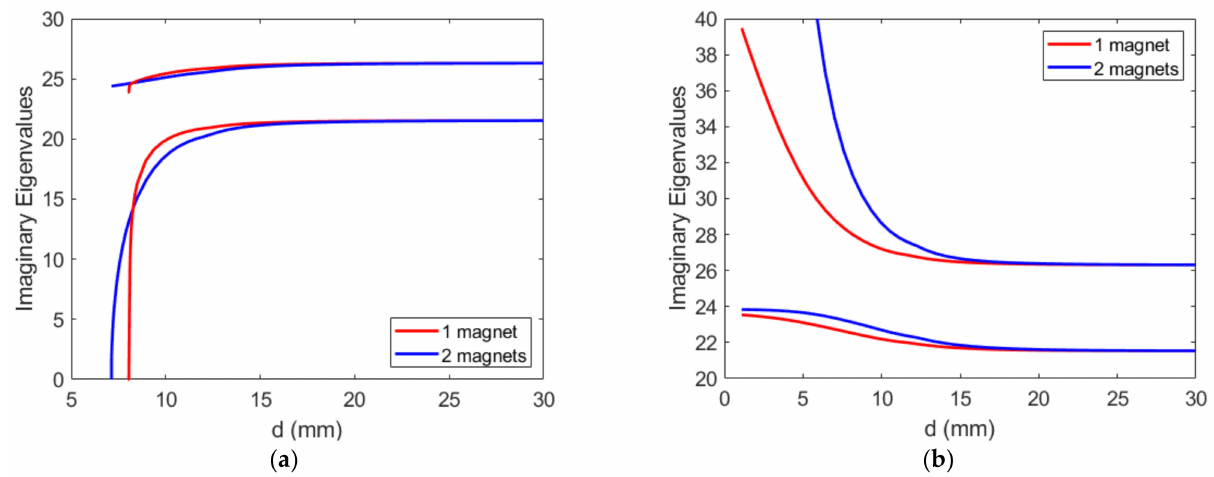
Figure 4. The effects of the magnetic forces on the coupled natural frequencies of the system when the magnets are ( a ) attractive and ( b )